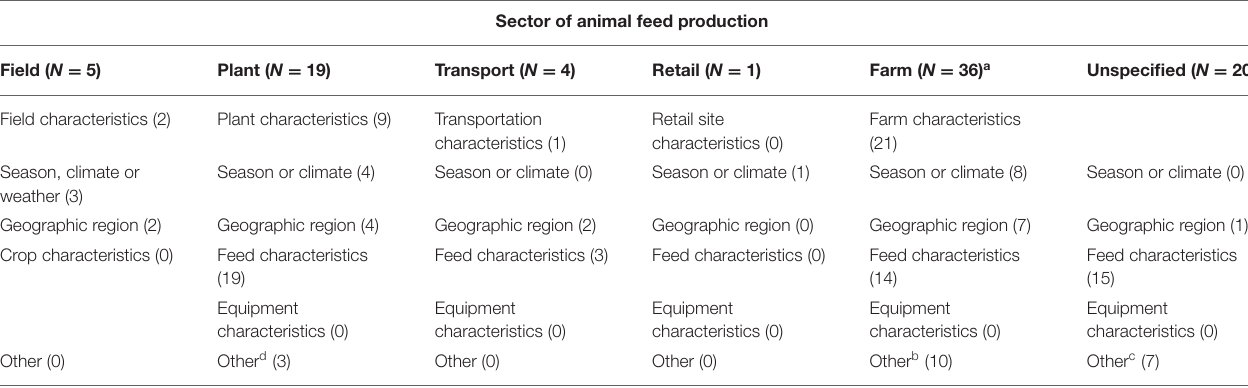
TABLE 6 | Summary of 83 risk-factor studies (number of studies) evaluating Salmonella in animal feeds, feed equipment and feed environment across sector of animal feed production.